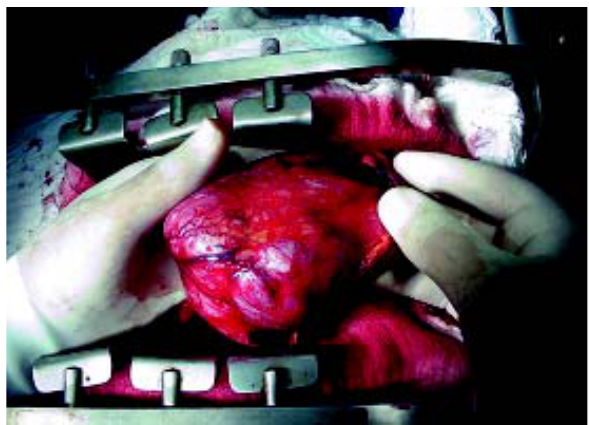
Fig. 1 - Timoma após descolamento ocupando o mediastino médio